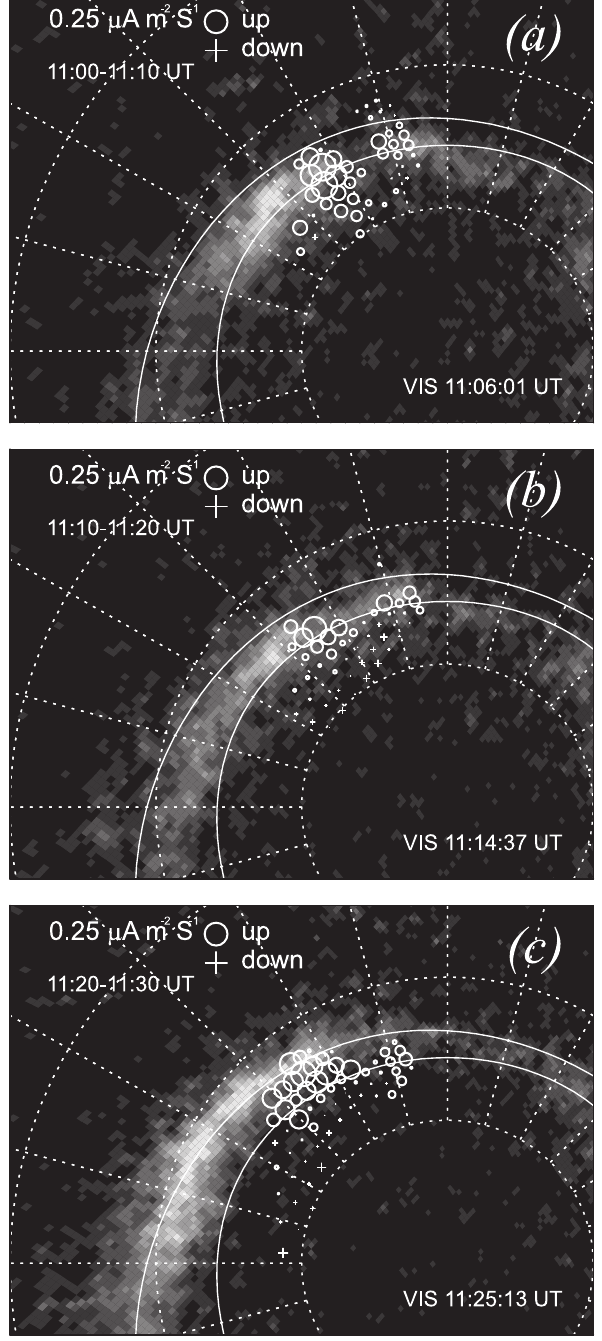
Fig. 8. The 10 minute plasma vorticity maps from 11:00–11:30 UT. The circles represent the HF radar estimate of the amount of upward FAC per unit Pedersen conductance B · ( ∇ × v ) ( µ A m − 2 S − 1 ), and the crosses represent the downward. The FAC estimates have been overlaid onto the VIS Earth Camera images that occur closest to the centre of the 10 minute averages. A quiet time statistical auroral oval has also been added. In all panels of Fig. 8 there is a band of upward FAC co-located with the intense ultraviolet aurora and this band has an average FAC density of approximately 0.2 µ A m − 2 S. In panels (b) and (c) the upward FAC is flanked on the poleward edge by a band of downward